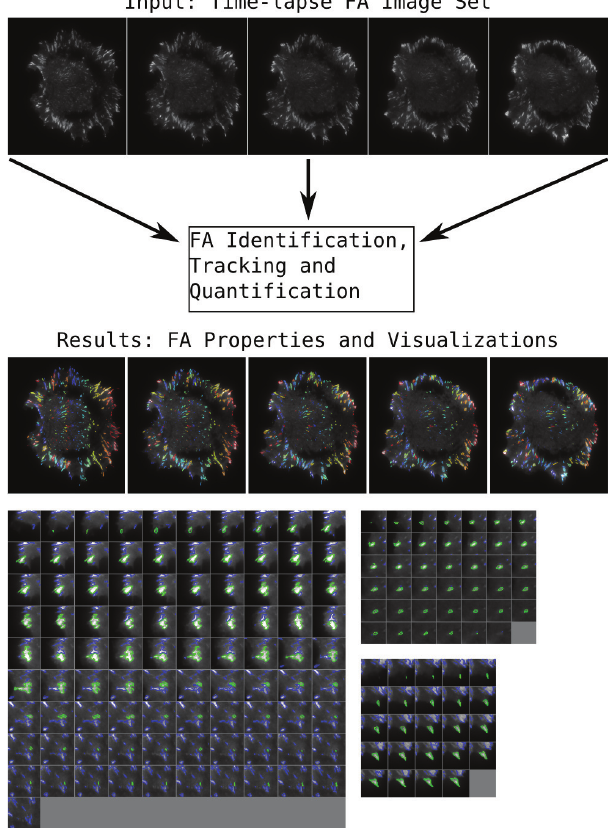
Figure 1. Sample input images and output visualization from the focal adhesion processing pipeline. The results section shows examples from the visualizations produced by the pipeline. In the top example, the entire cell is shown, with an individual adhesion outlined and tracked through time. The bottom three examples show single adhesions, outlined in green, with other nearby adhesions outlined in